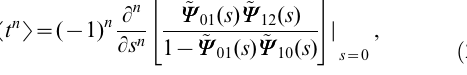
q ij t ) . Observable state j